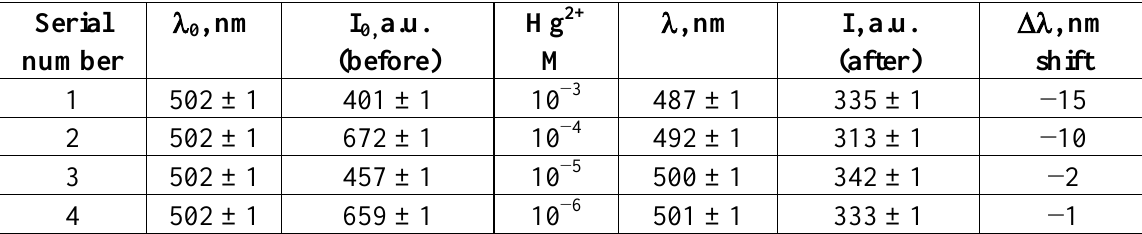
Table 3. The wavelength for the fluorescence maximum (nm) and absorption intensity (a.u.) for the polymer-dye film based on PVC before (  Hg(ClO ) solutions. 4 2